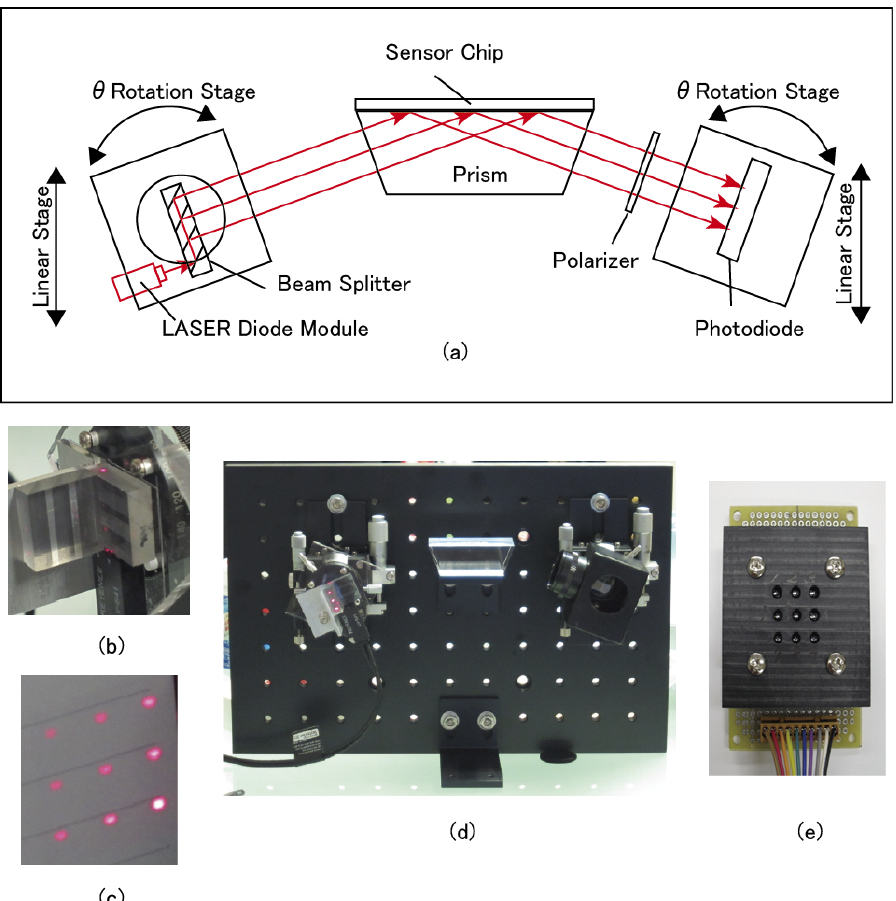
Figure 3. ( a ) Optical System for the 2D SPR Sensor. ( b ) Multiplied beam splitter with LD light source. ( c ) Nine beams projected on the paper at the exit of the multiplied beam splitter. ( d ) Photo of optical system. ( e ) Arrayed photo diode